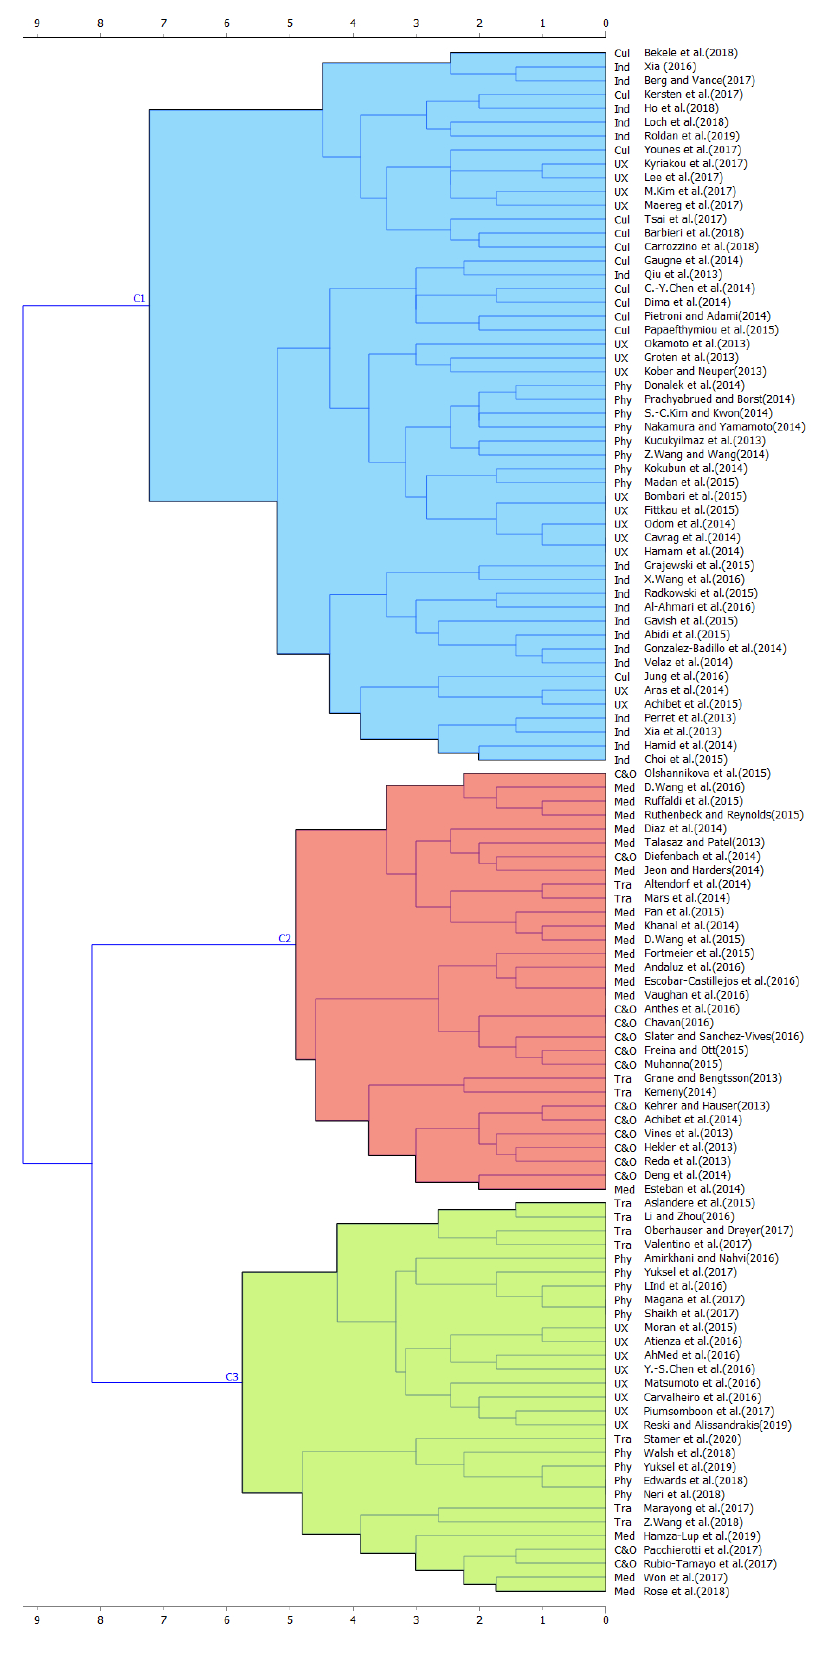
Figure 6. Dendrogram of the cluster